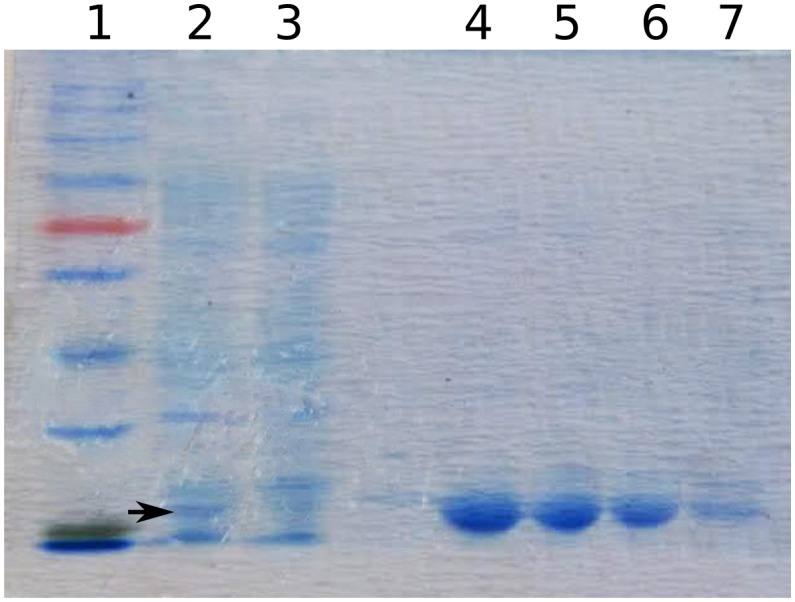
10165 (BefA) protein purification.SDS-page gel image showing subsequent steps in the purification of BefA (black arrowhead) from E. coli cell lysate; lane 1: ladder, lane 2: cell lysate after IPTG induction, lane 3: supernatant from cell lysate after addition of nickel beads, lanes 4-7: elutions of BefA from beads.